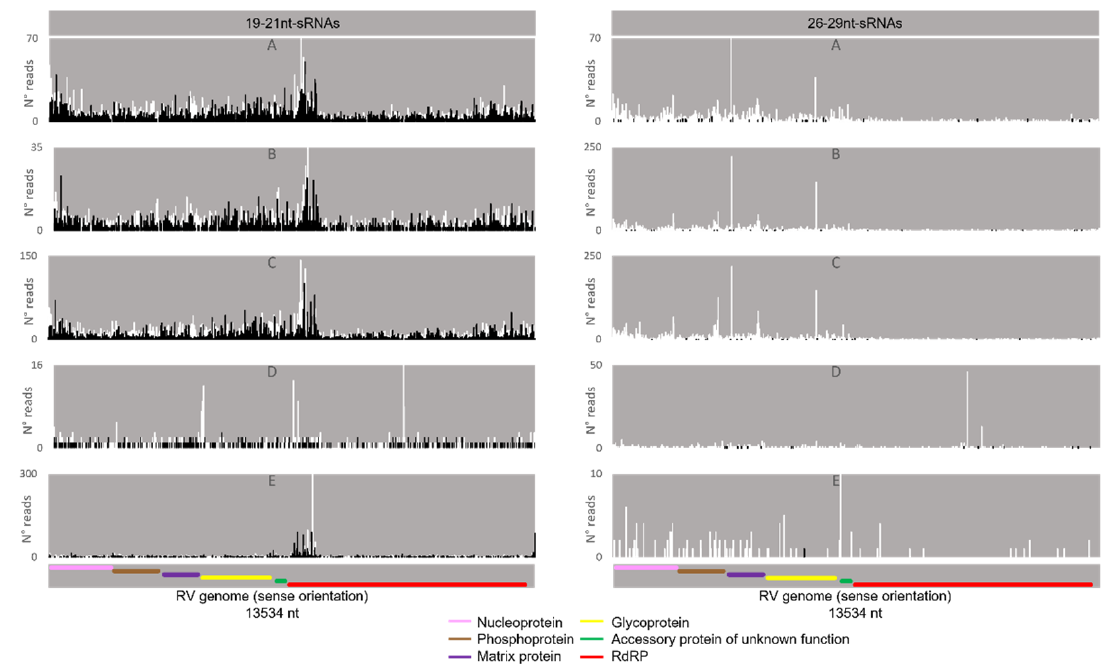
Figure 7. Distribution of BmN4 sRNAs mapping to B. mori Macula-like Latent Virus (MLV). Left: distribution of 19–21 nt-long sRNAs. Right: distribution of 26–29 nt-long sRNAs. White bars: sense reads. Black bars: anti-sense reads. A–E: represented databases, listed in Table S2. Red: RdRp ORF; blue: coat P ORF; orange: p15 ORF.